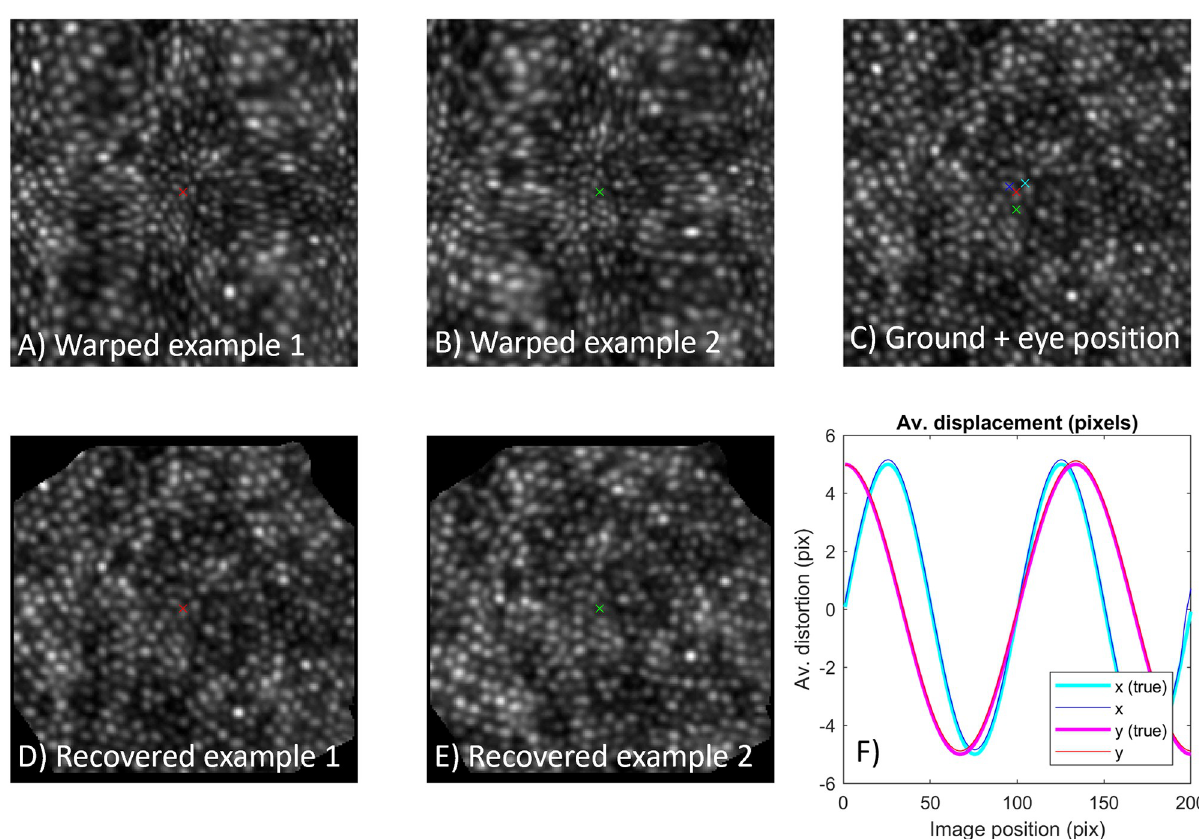
Fig 5. Example correction in the presence of rotation. Four distorted frames were generated with the eye at positions as for Fig 1, however now with rotation spanning 50˚ between the 4 frames. Example images are shown (A, B) which are rotated by 30˚ with respect to each other. Image A is the same as that for Fig 3. Both example images are recovered with high accuracy (D, E) and recovered distorting profiles (F) match the ground truth, demonstrating robustness to image